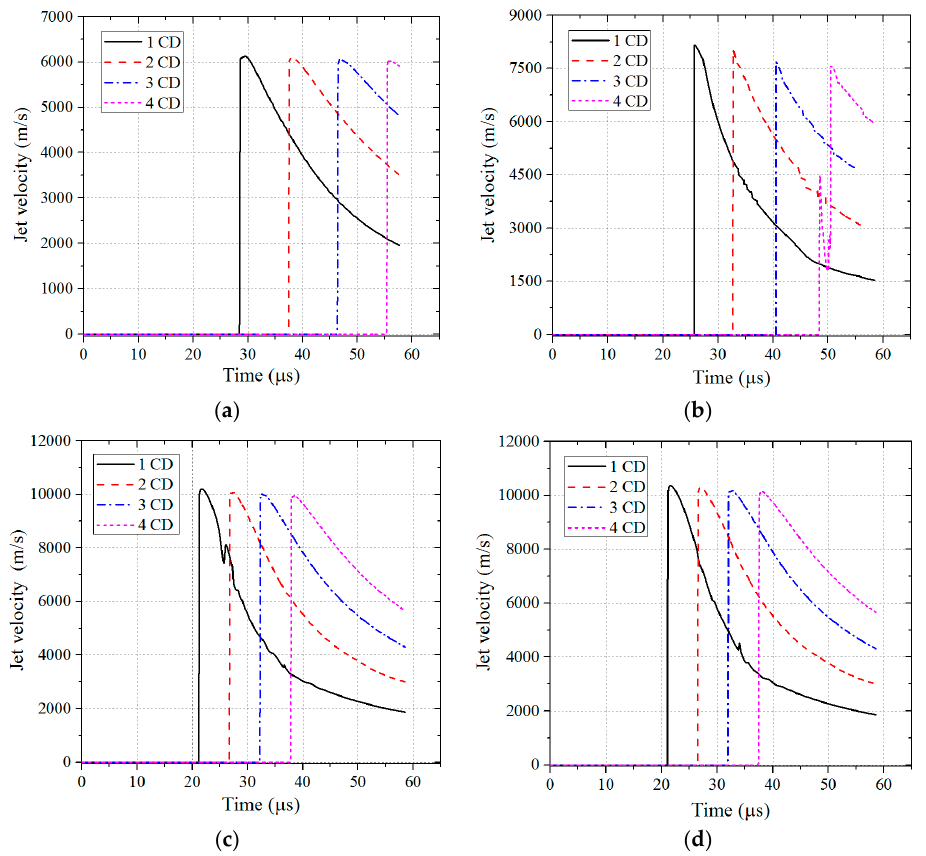
Figure 4. The velocity history corresponding to different stand-offs and different liner materials: ( a ) copper; ( b ) floatglass; ( c ) Lucite; and ( d ) Plexiglas.